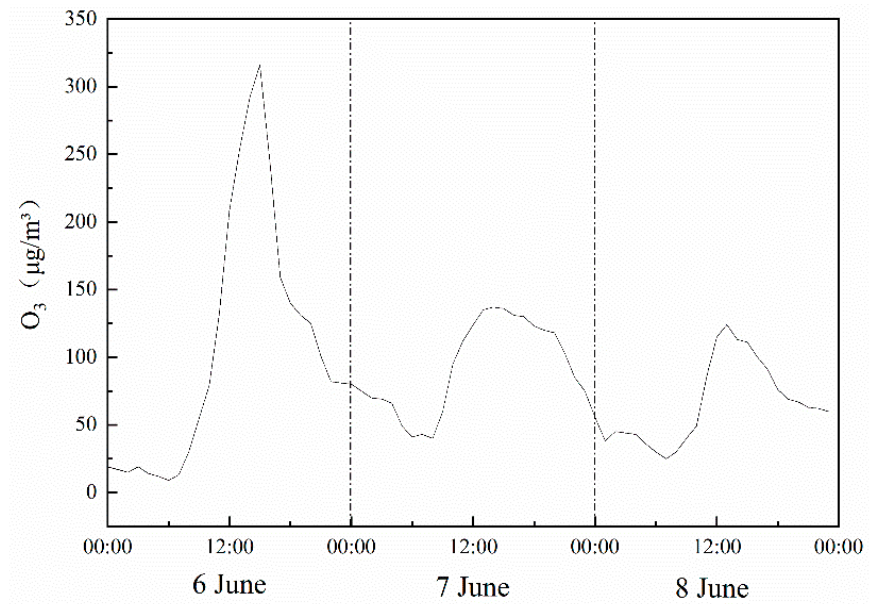
Figure 4. Diurnal variations of O 3 concentration in Taiyuan on a sunny day (6 June) and cloudy day (7 June and 8 June).